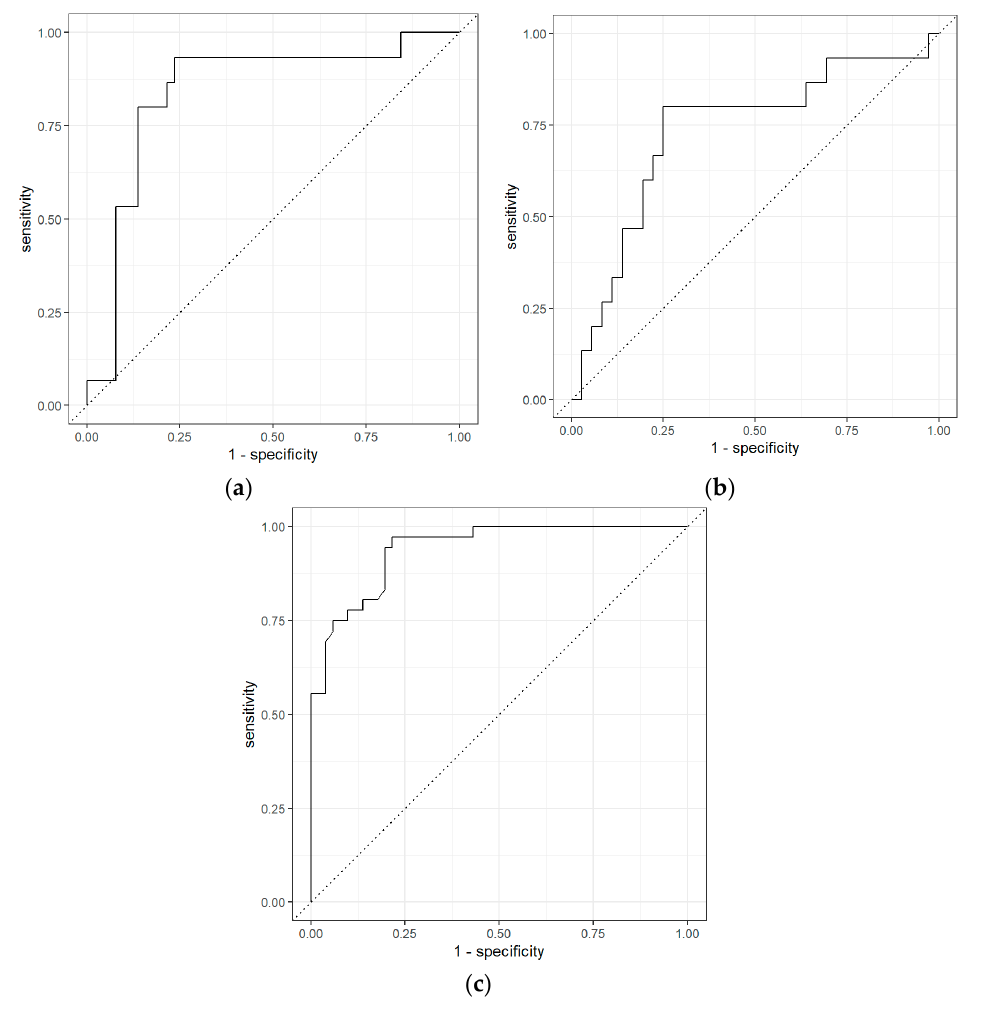
Figure 5. ROC for ( a ) bladder cancer vs. PCa; ( b ) bladder cancer vs. non-cancerous group; and ( c ) prostate cancer vs. non-cancerous group using GC-TOF-MS.